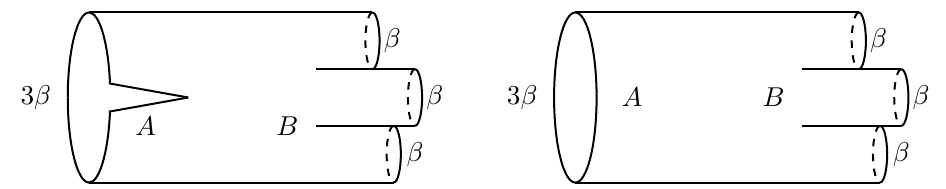
Figure 2 . Left: sketch of (cid:26) 3